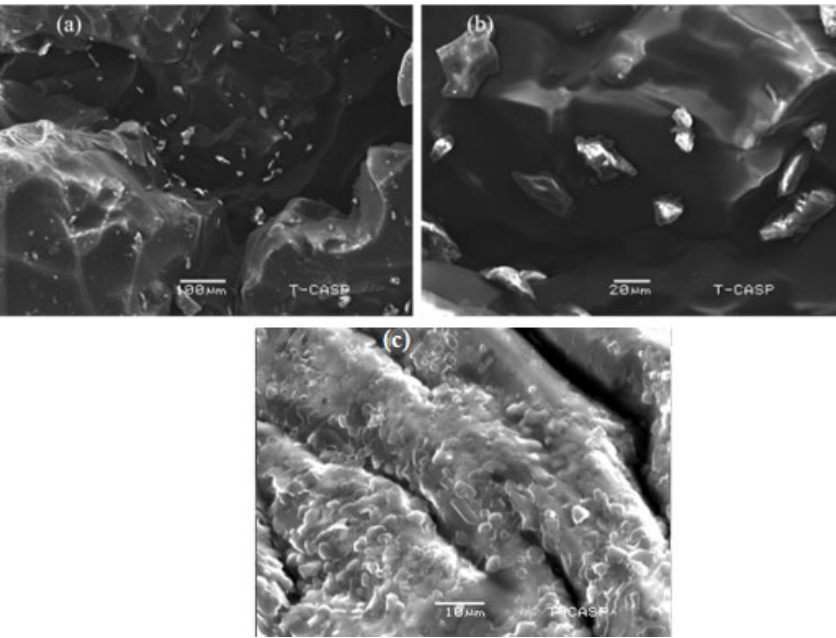
Figure 4. SEM of drug loaded nanogel at 100 μ m ( a ), 20 μ m ( b ), and blank nanogel at 10 μ m ( c ) formulations.